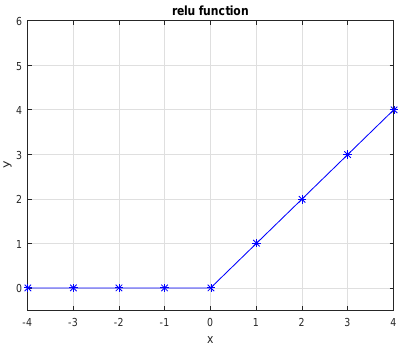
Figure 6. The curve of the relu function.